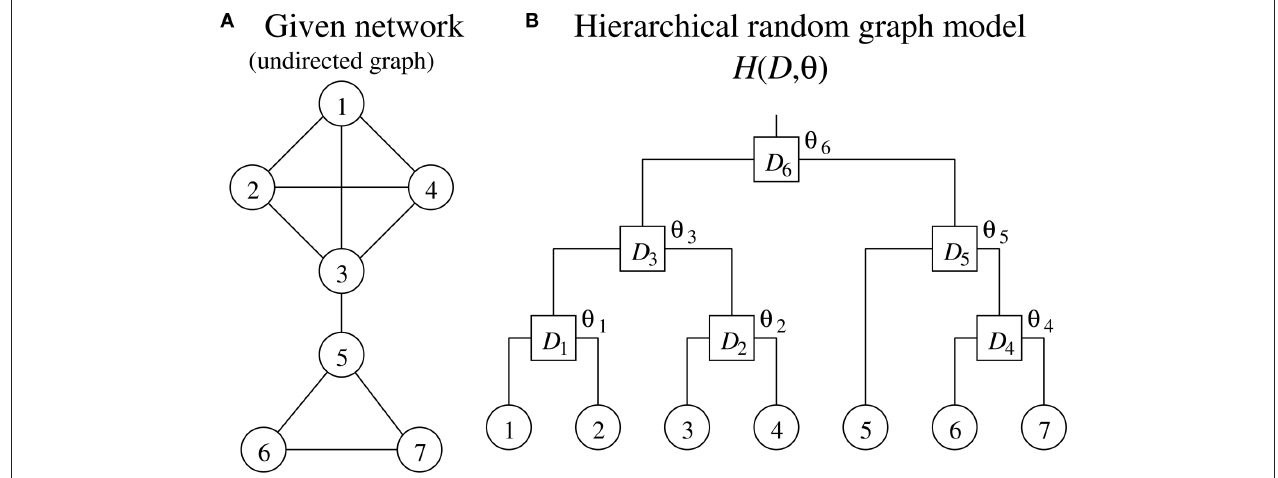
FIGURE 1 | (A) A network and (B) the corresponding hierarchical random graph